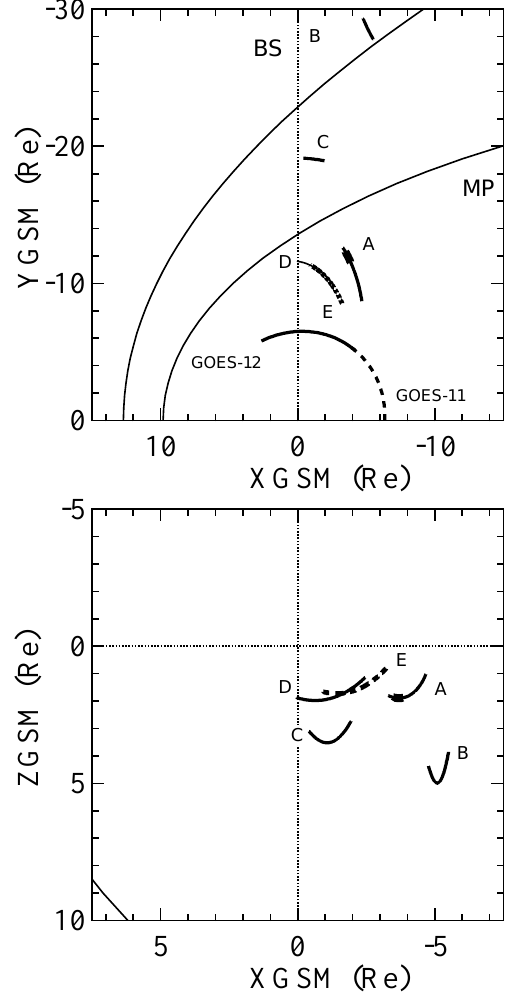
Fig. 1. Locations of THEMIS-A, B, C, D, E and GOES-11/12 in the GSM X-Y and X-Z planes from 08:00UT to 12:24UT on 7 Novem- ber 2007. Grey shading marks the portion of the THEMIS-A orbit from 11:00UT to 12:15UT. The locations of the bow shock and magnetopause were chosen to place the spacecraft in the observed regions of geospace during this